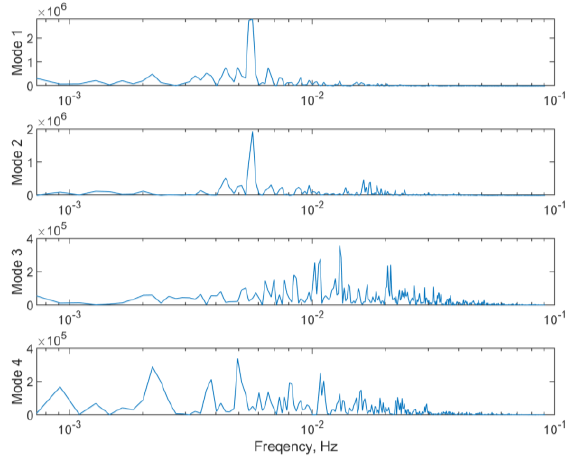
Fig. 6. Spectra of time dependant POD coefficients for 4 main